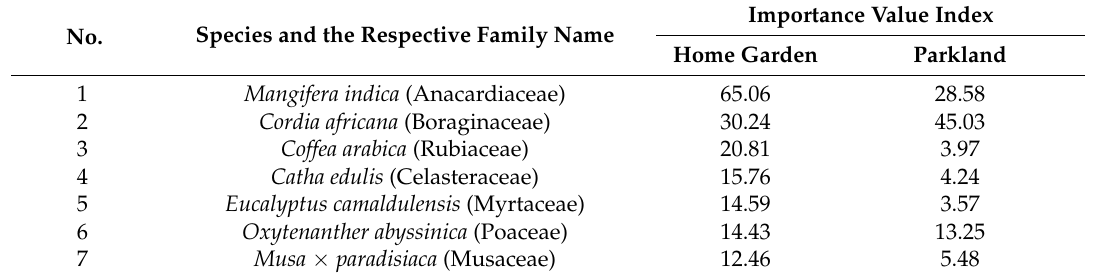
Table A3. The importance value index (IVI) of woody and herbaceous perennial species common to parklands and home gardens of Assosa district, western Ethiopia.